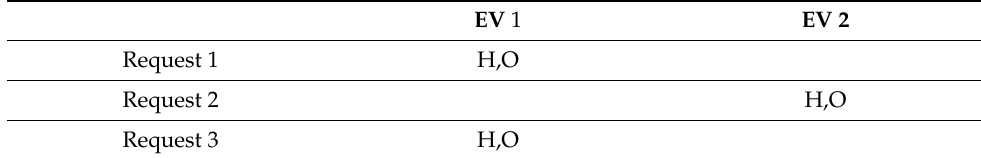
Table 2. Request assignment in Example 1.